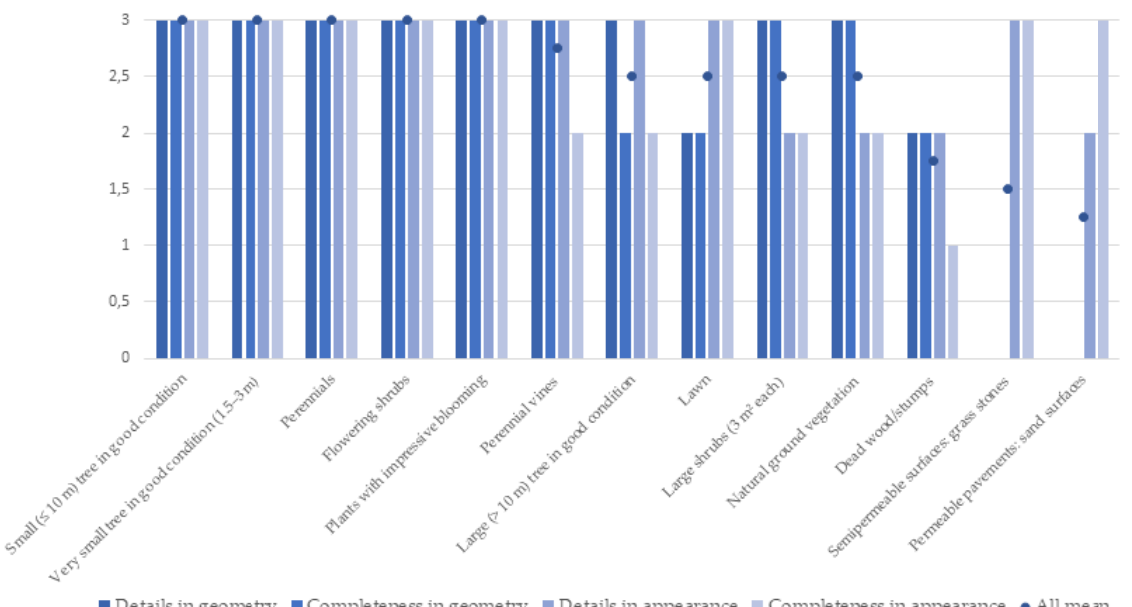
Figure 16. The best-performing results of all of the point cloud data sets to convey information on green elements, 3 being the top score (good ability to convey information) and 0 (no ability to convey information) being the lowest score.